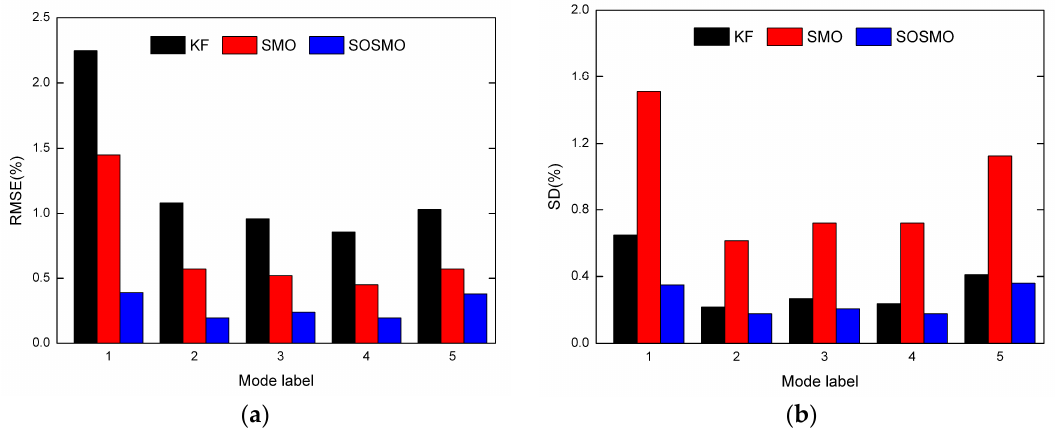
Figure 9. The average RMSE and SD for each fault mode (Mode 1 to 5) in scenarios with uncertainties. ( a ) The average RMSE results; ( b ) The average SD results. Table 2. The detection times of SOSMO scheme in scenarios with uncertainties (s).